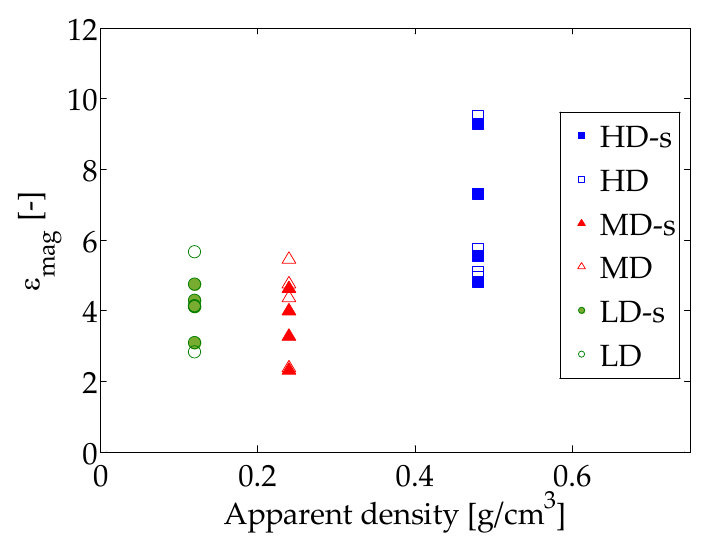
Figure 16. Scatter plot of the equivalent strain magnification at the apparent ultimate point as a function of the apparent density group of the